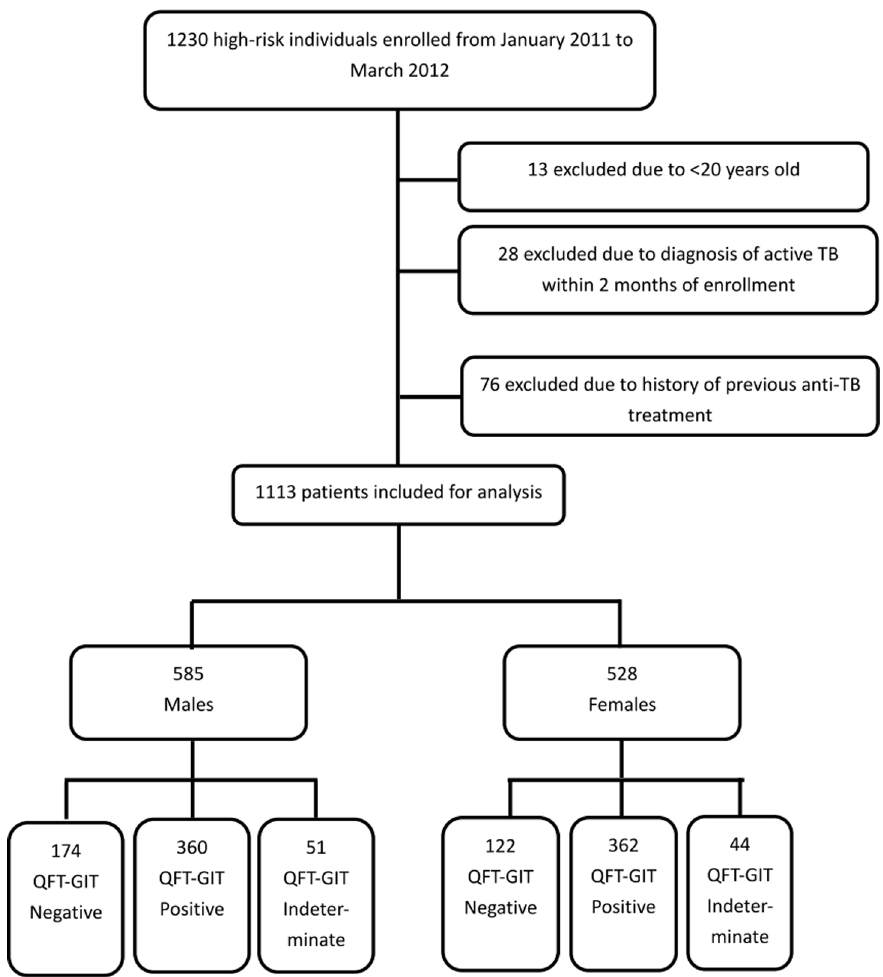
Figure 1. Study profile demonstrating the number of cases and reasons for exclusion.